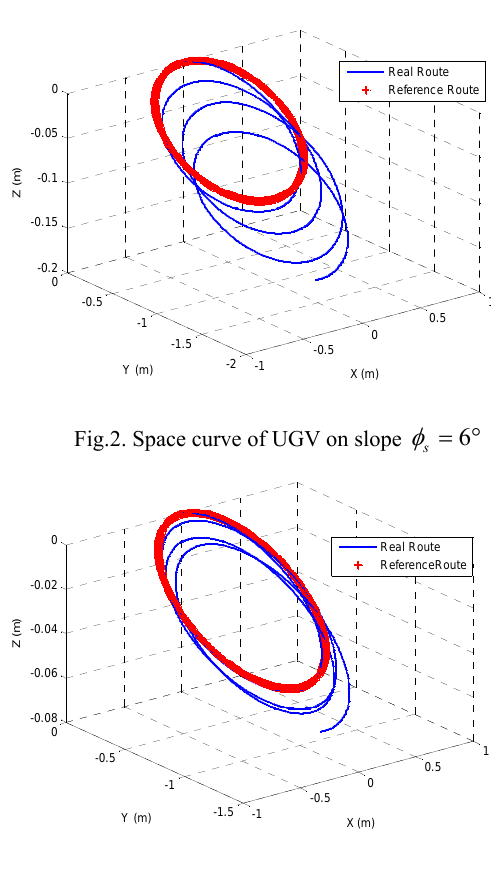
Fig.3. Space curve of UGV on